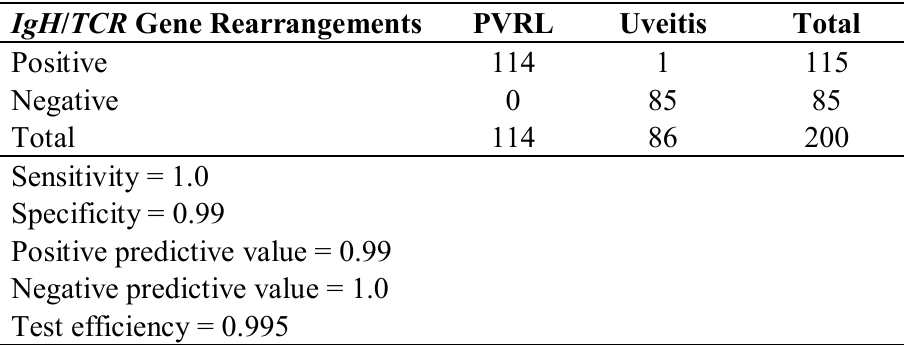
Table 4. Molecular analysis.